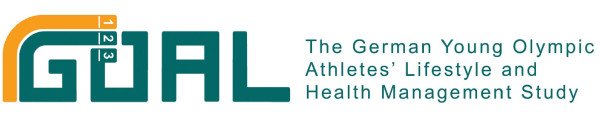
Logo GOAL Study.